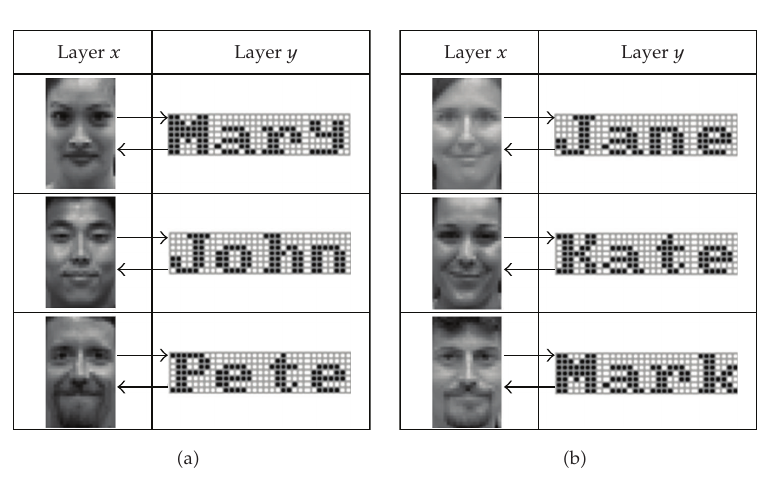
Figure 12: Patterns pairs used to trained the